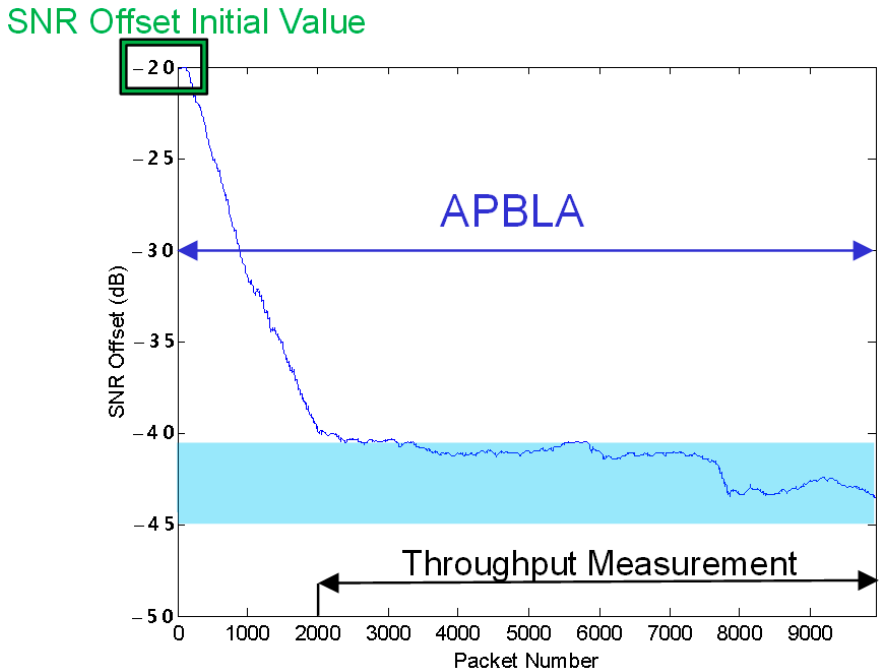
Figure 23. SNR offset variation over time in case of APBLA only (test T3).